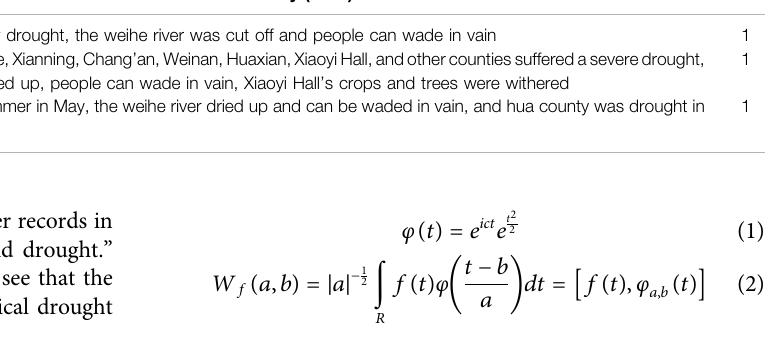
TABLE 2 | Criterion of drought and fl ood events of huaxian county in 1852. different